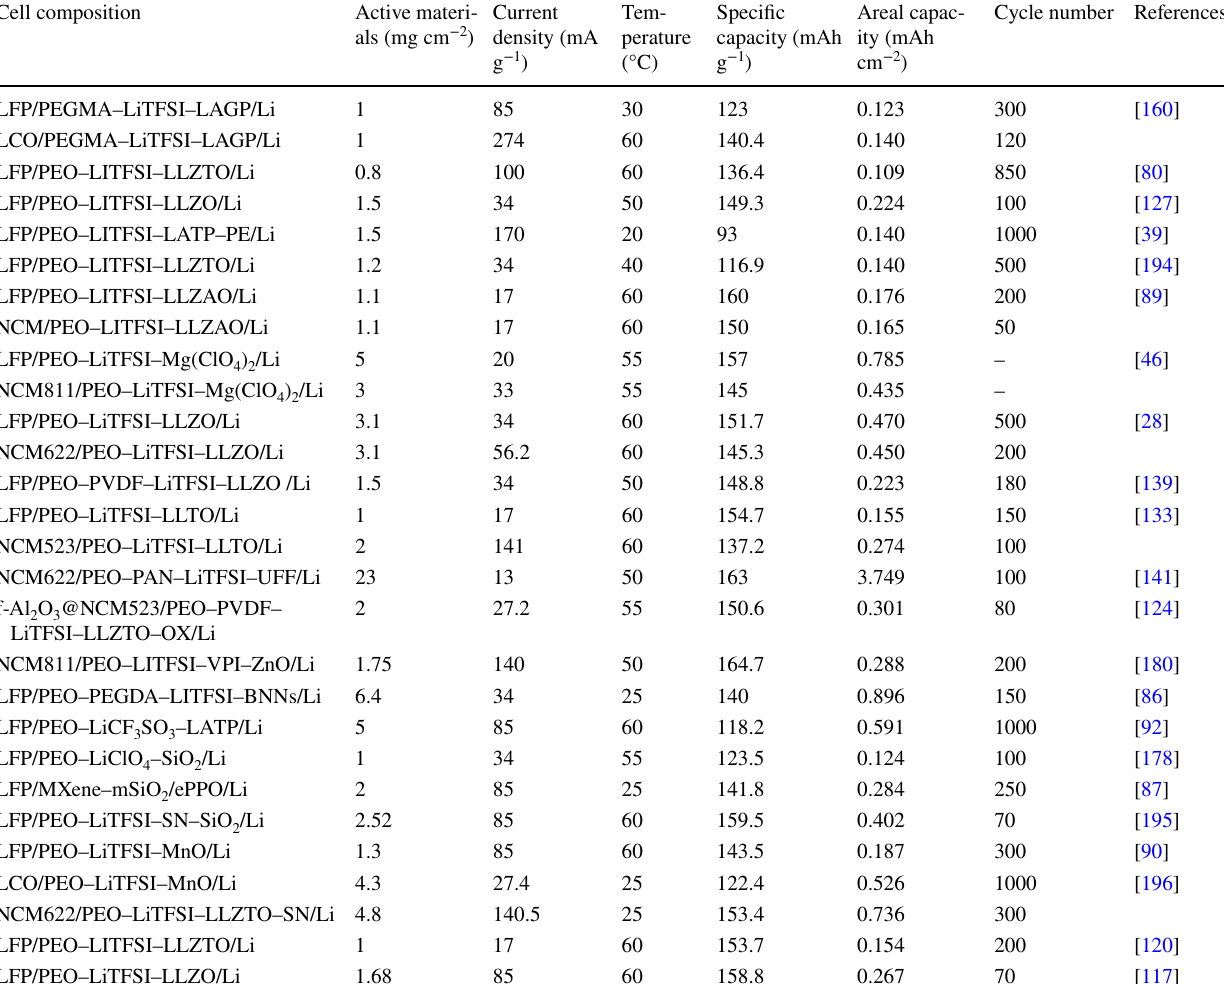
Table 3 Performance comparison of various lithium metal batteries with PEO/ceramic CSEs Cell